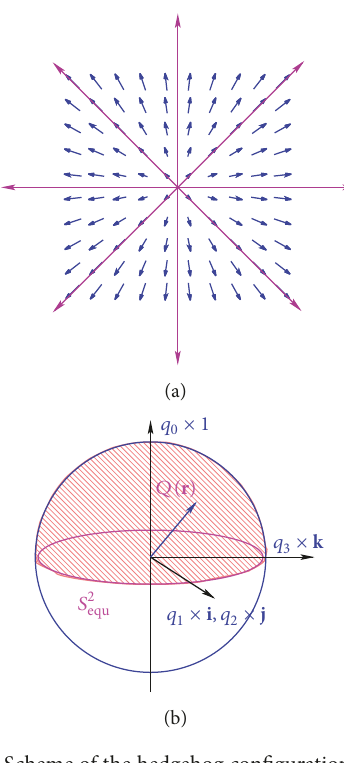
󳨀→ 󳨀→ 𝑞 = 𝑛( r ) sin 𝛼(𝑟) of the 𝑄 -